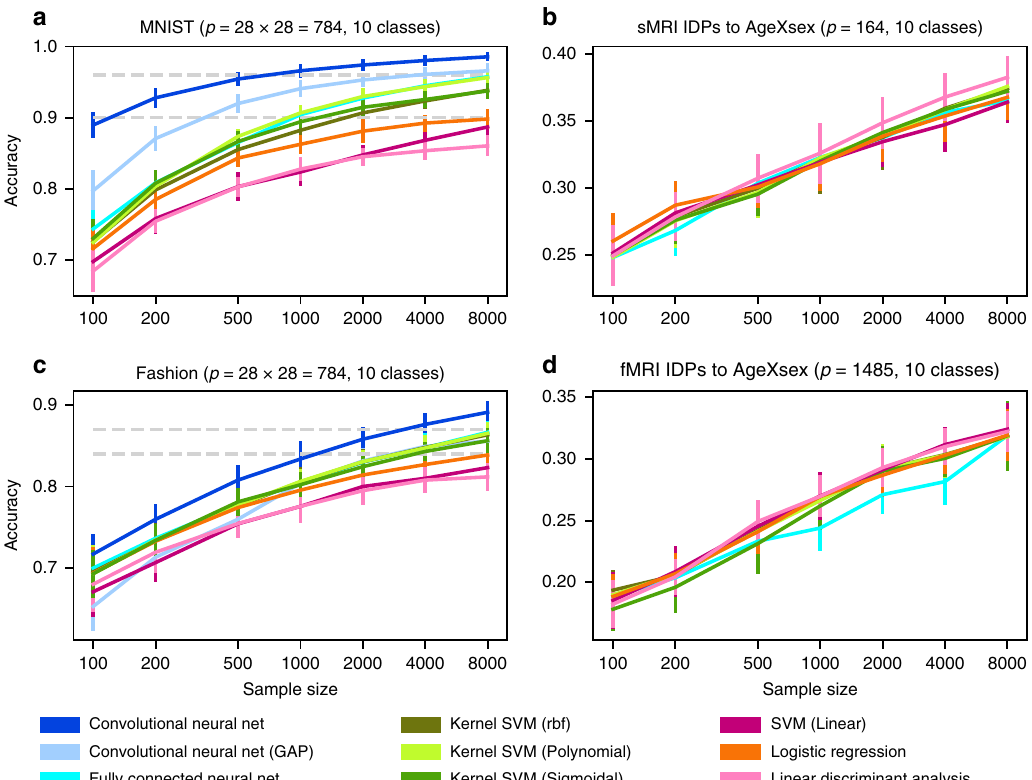
Fig. 2 Classi fi cation performance gains with more powerful algorithms in two machine learning datasets. Shows performance scaling of prediction accuracy ( y axis) as a function of increasing sample size ( x axis) for generic linear models (red tones), kernel models (green tones), and deep neural network models (blue tones). All model performances are evaluated on the same independent test set. a In handwritten digit classi fi cation on the MNIST dataset, the classes of three linear, three kernel, and three deep models show distinct scaling behavior: linear models are outperformed by kernel